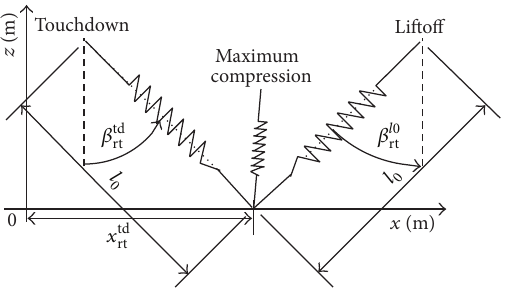
Figure 3: Stance phase of the rear tailing leg.